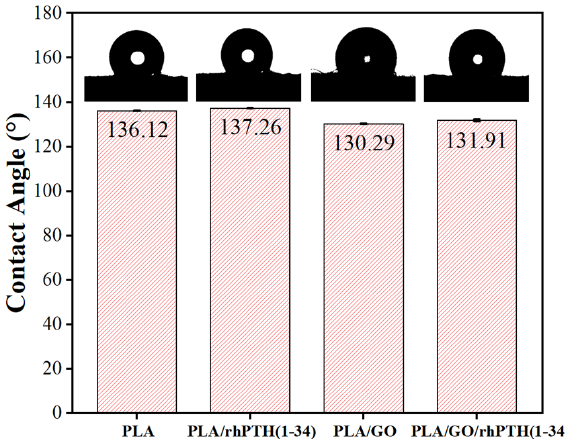
Figure 4. Water contact angle test results for different electrospun membranes. The contact angle is plotted as a function of composite membranes. The inset digital photos show the water droplets on the membranes (Notes: p > 0.05 stands for no significant difference).